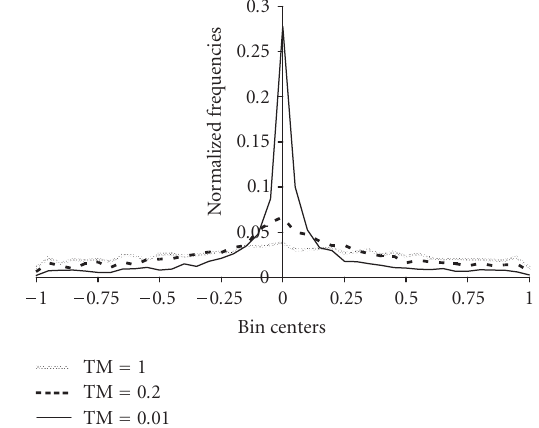
Figure 3: Normalized histogram of the values obtained by means of the random number generator described in (9) for di ff erent values of the parameter TM